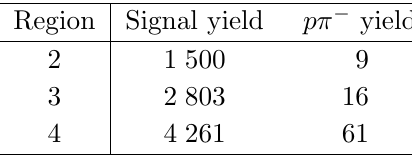
Region Signal yield